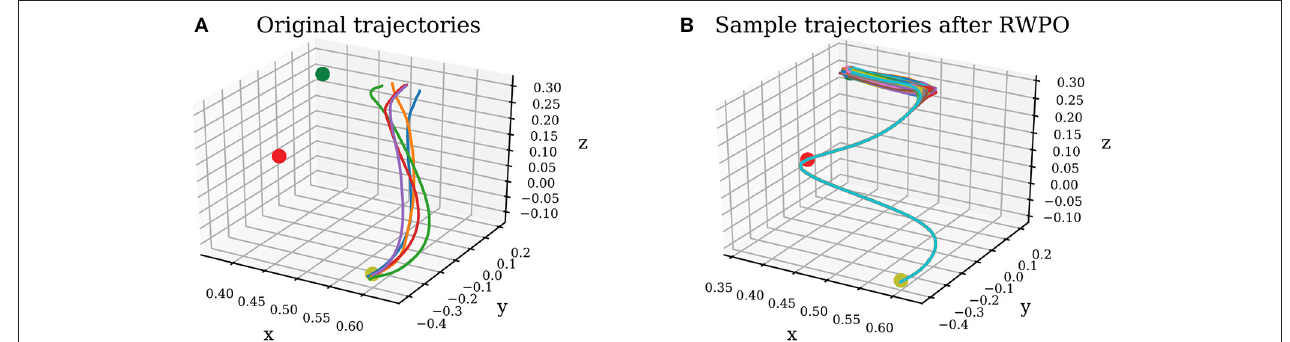
FIGURE 13 | (A) Original trajectories. (B) Sample trajectories after Relevance Weighted Policy Optimization (RWPO).